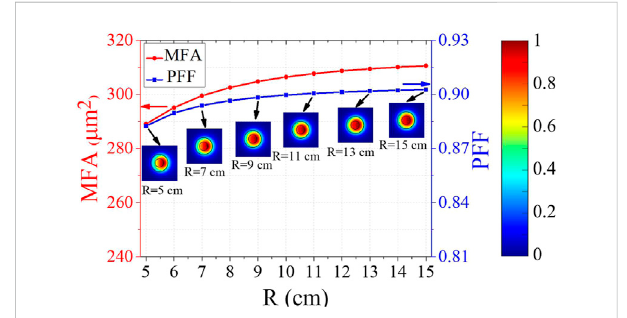
FIGURE 7 MFA (red line) and PFF (blue line) as a function of bending radius. Insets show mode fi eld distribution under different bending radii.